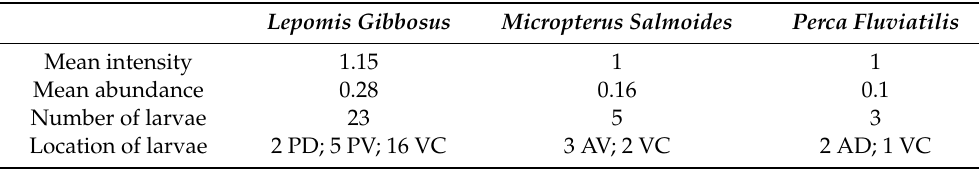
Figure 2. Larvae of Eustrongylides spp. (red circles) in (a) the visceral cavity of Lepomis gibbosus and (b) in the posterior dorsal portion of musculature in Perca fluviatilis . Table 2. Mean intensity and mean abundance of infestation and number and location of larvae in the musculature (anterior ventral (AV), anterior dorsal (AD), posterior ventral (PV), and posterior dorsal (PD)) and in the visceral cavity (VC).